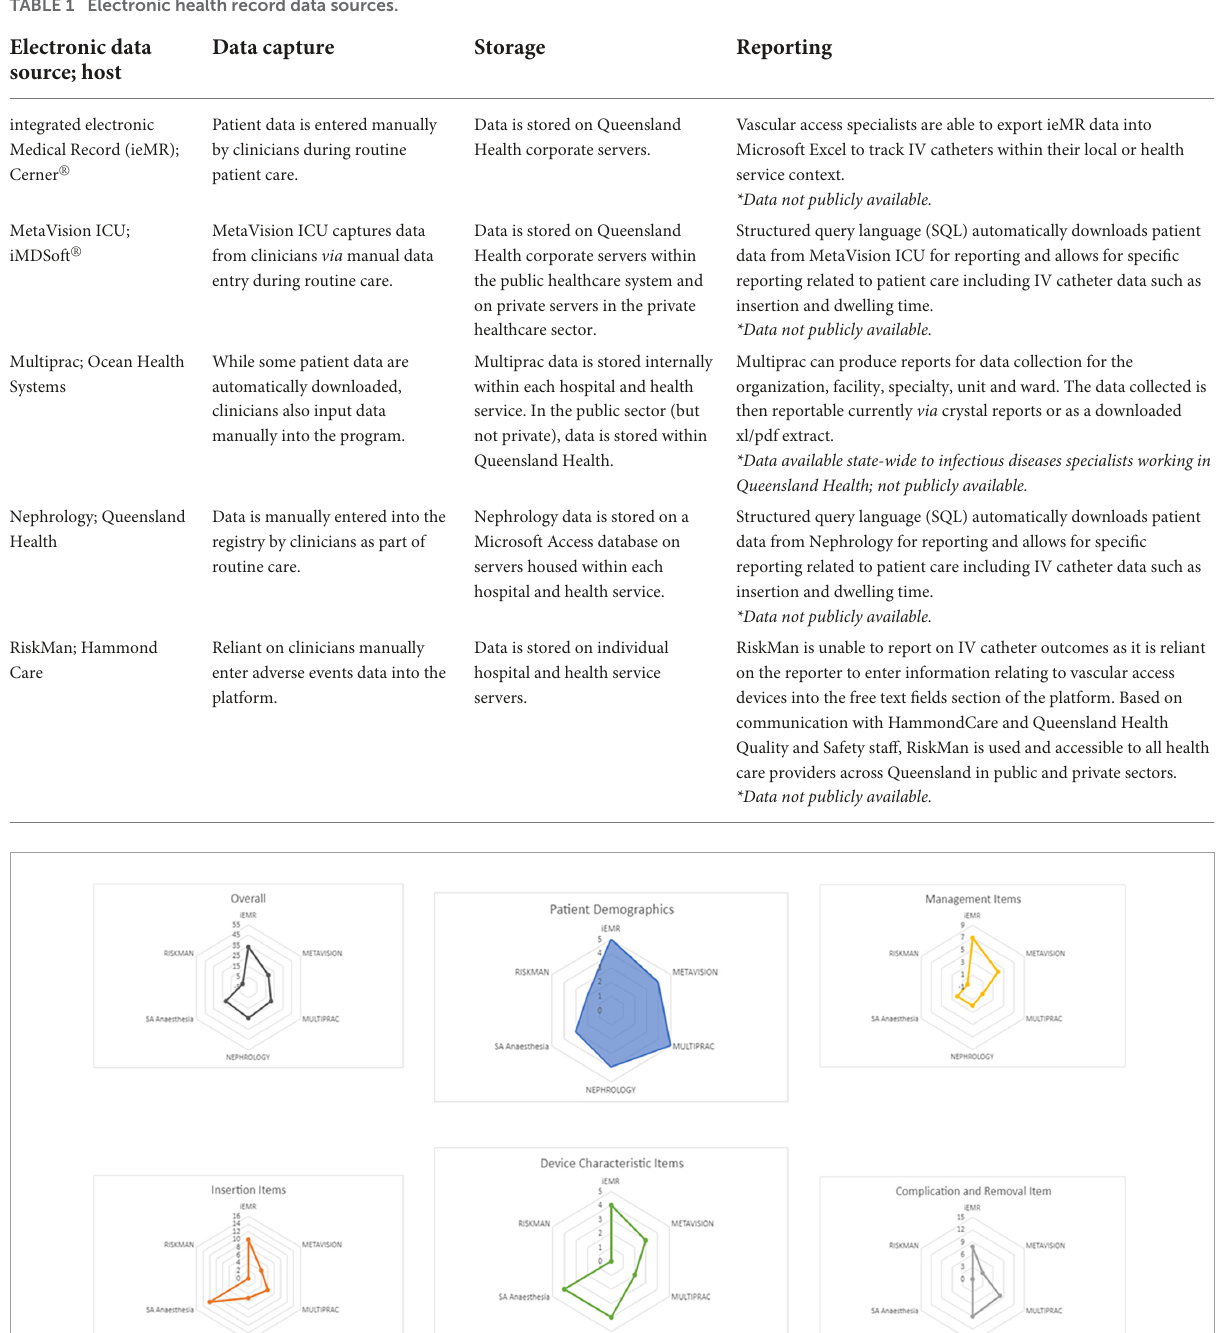
TABLE 1 Electronic health record data sources.